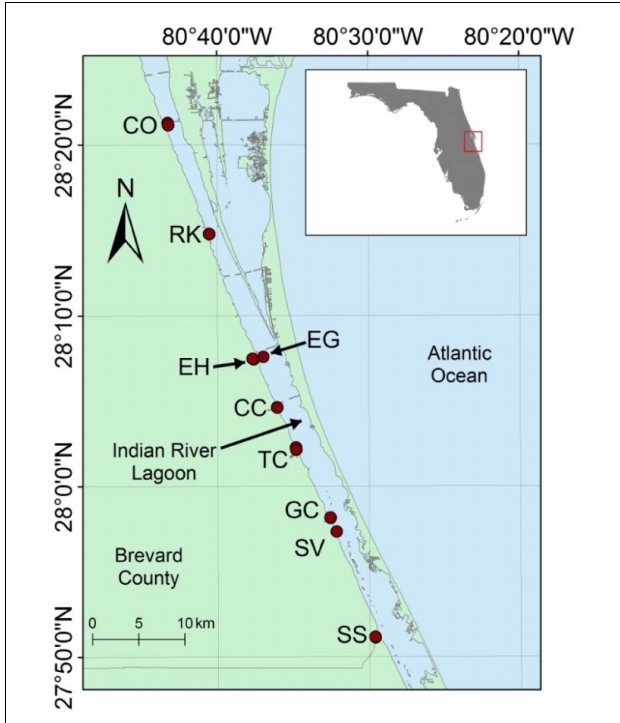
FIGURE 1 | Map showing sampling locations in the Indian River Lagoon (IRL), Florida. From north to south, the stations are as follows: Cocoa (CO), Rockledge (RK), Eau Gallie (EG), Eau Gallie Harbor (EH), Crane Creek (CC), Turkey Creek (TC), Goat Creek (GC), South Valkaria (SV), and Saint Sebastian River (SS). Inset map shows IRL along east central coast of